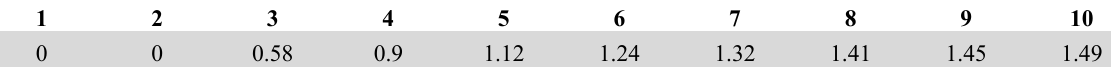
Random Consistency Index Value.